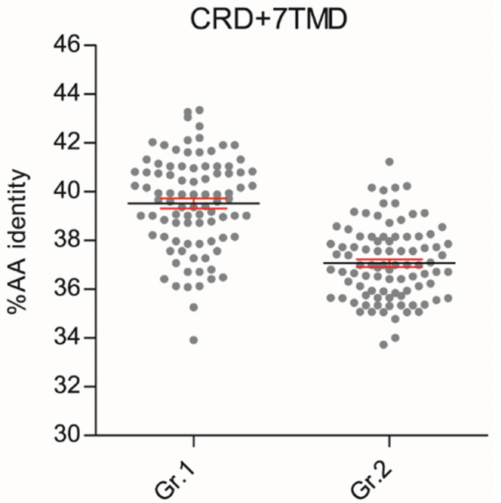
Figure 2. Scatter plots of amino acid conservation within the 9-Cystein-Rich and heptahelical transmembrane domains (CRD + 7TMD, ± 348 AAs) of fish T1R2 versus tetrapod T1R1 (Gr.1) or tetrapod T1R2 (Gr.2). Each dot represents the percentage of AA sequence identities calculated in one-to-one combinatorial arrangements ( n = 90) of fish T1R2s ( n = 13) with T1R1 ( n = 7) or T1R2 ( n = 7) tetrapod sequences. T-test analysis of variance followed by Mann Whitney test was implemented to show significant di ff erences between the two groups ( p < 0.0001); percentage AA identity mean (black line) ± SEM (in